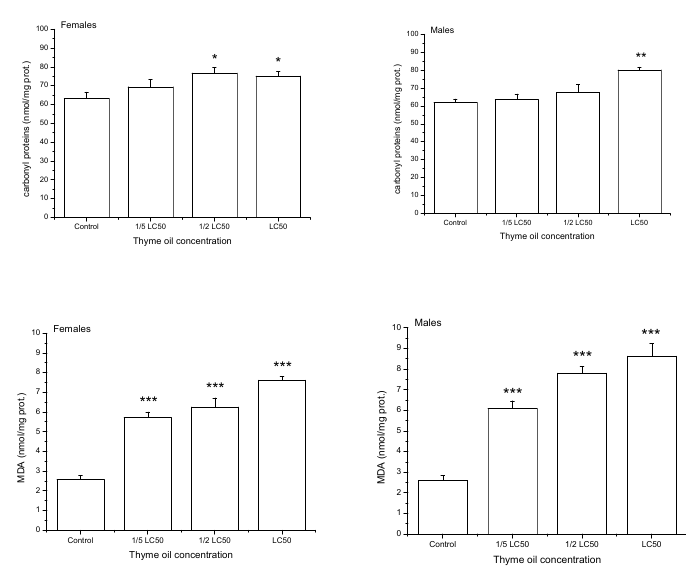
Figure 4. Carbonyl proteins and malondialdehyde (MDA) contents (means and standard errors for 5 replicates) in Acanthoscelides obtectus adults one day after exposure to bean seeds treated with thyme oil. Significant differences in treatment groups from the control are marked by asterisks (* p < 0.5, ** p < 0.01, *** p < 0.001). On average, one-day exposure to increasing thyme EO concentrations reduced levels of total thiols (T-SH) and high-molecular mass thiols (H-SH) (T-SH: F 3,32 = 25.33, p < 0.0001, H-SH: F 3,32 = 29.09, p < 0.0001, Figure 5). Low-molecular mass thiols (L-SH) were also significantly influenced by thyme EO concentration (F 3,32 = 4.08, p = 0.0146) but changes in their level were less expressed. On average, the highest L-SH value was recorded in 1/2 LC 50 group, even higher than in the control one (Duncan post hoc test, p = 0.0413), 1/5 LC 50 ( p = 0.0029) and LC 50 group ( p = 0.0430). T-SH level did not differ between the sexes (F 1,32 = 1.47, p = 0.2336) but females had less H-SH (F 1,32 = 4.54, p = 0.0410) and slightly more L-SH than males (F 1,32 = 3.32, p = 0.0776). Differences in H-SH level between females and males were marginally dependent on EO concentration (F 3,32 = 2.27, p = 0.0999) and significant difference was recorded only at the highest examined concentration, where males had more H-SH than females (Duncan post hoc test, p = 0.0035). Concentration × sex interaction was significant for T- SH (F 3,32 = 15.11, p < 0.0001) and L-SH (F 3,32 = 13.32, p < 0.0001). While females exposed to acetone showed higher levels of T-SH ( p = 0.0013) and L-SH ( p < 0.0001) than males, the opposite trend was noticed when insects were exposed to LC 50 thyme EO ( p < 0.0001, p = 0.0108 for T-SH and L-SH, respectively).